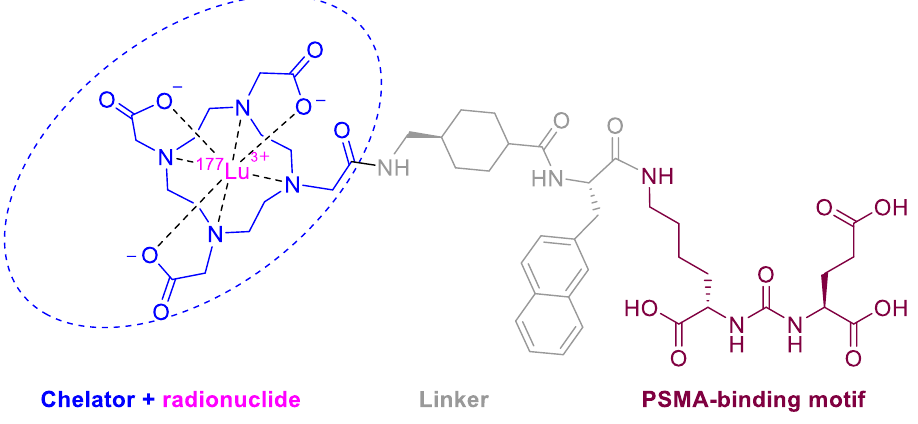
Figure 5. Structure of 177Lu vipivotide tetraxetan.